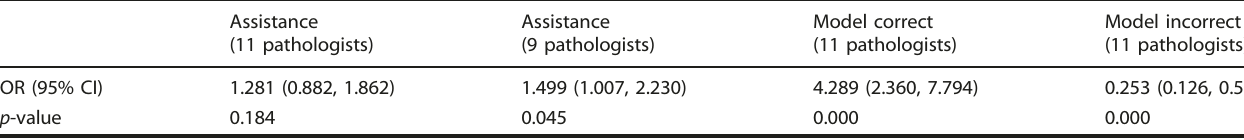
Table 3. Impact of assistance on diagnostic accuracy under different conditions a